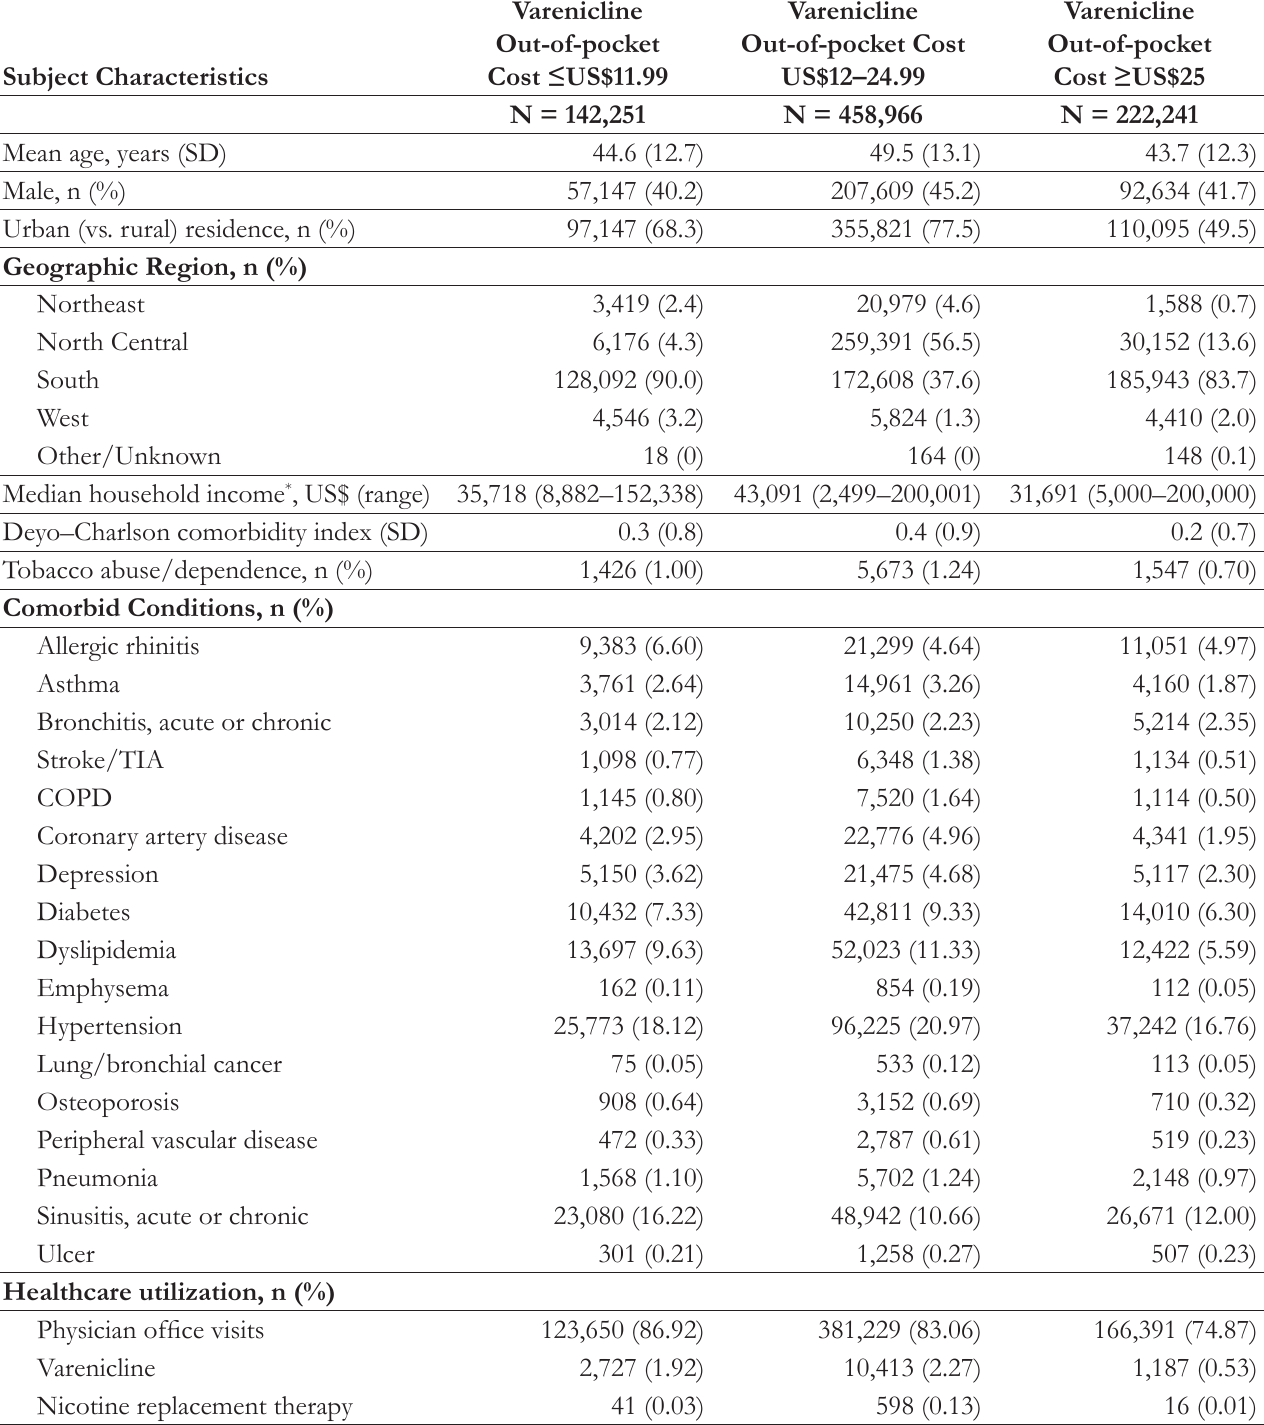
Table 1. Demographic and Pre-index Clinical